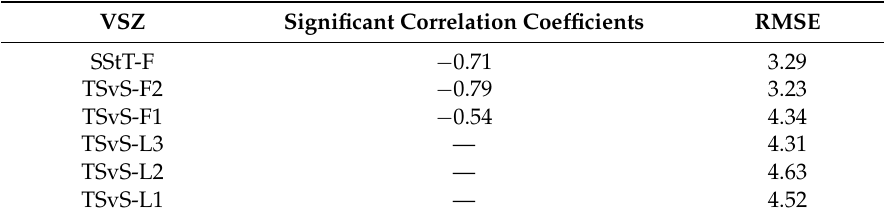
Table 5. Significant correlation coefficients after application of the Student t -test with a 5% threshold between duration of dry spell (with SM) and maximum of LAI from (JJAS) and the corresponding Root Mean Square Error (RMSE) on each VSZ (see Table 3 for the